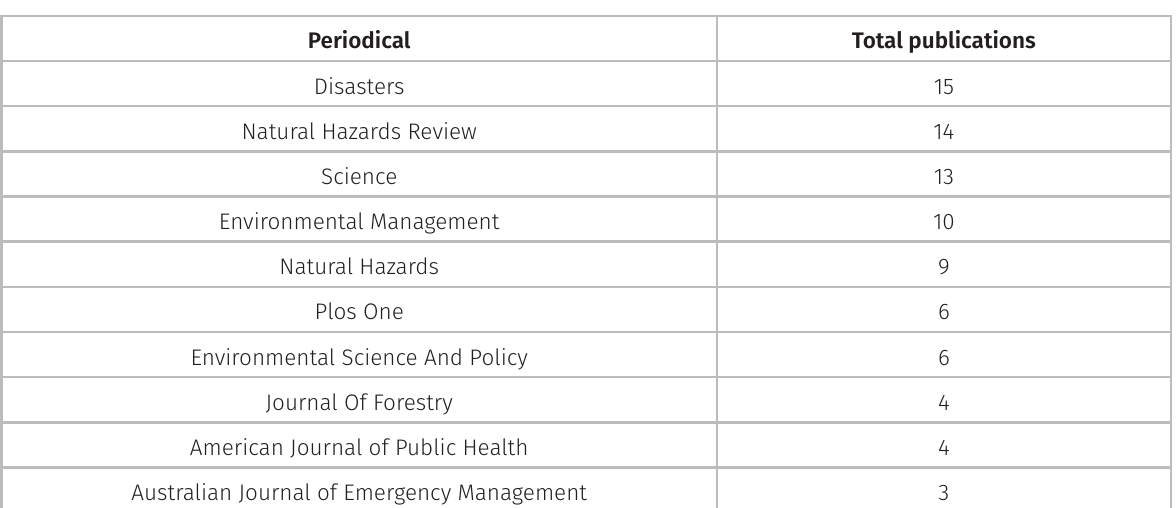
Table IV. Periodicals that publish the